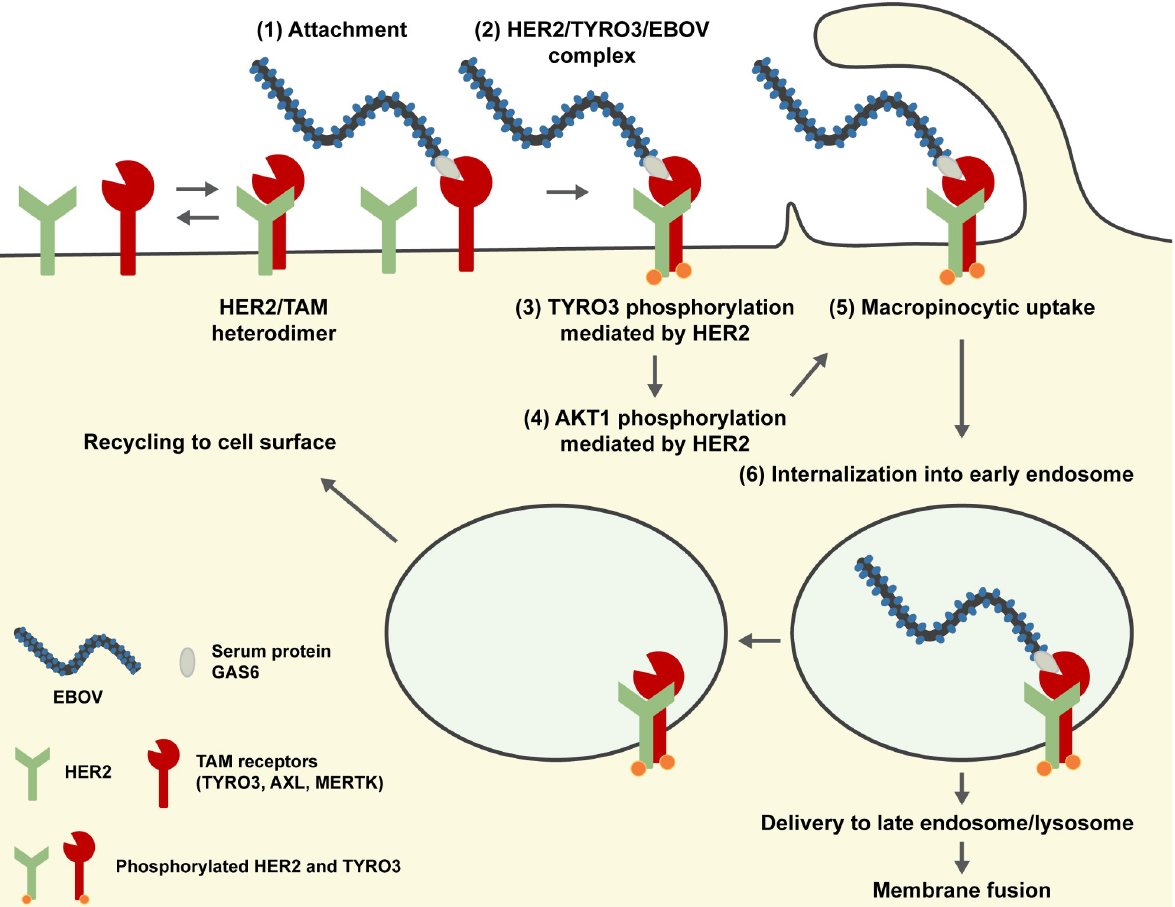
Fig 8. Proposed model of EBOV entry into cells expressing HER2 and TYRO3. HER2 interacts with all members of the TAM (TYRO3, AXL, and MERTK) receptor family to form heterodimers. In TAM receptor-mediated cellular entry, EBOV particles attach to the cell surface by binding to a TAM receptor (e.g., TYRO3) via the serum protein GAS6 (1). HER2 also interacts with the virus-bound TYRO3, forming a HER2/TYRO3/EBOV complex on the cell surface (2). The formation of this complex leads to HER2 phosphorylation (either autophosphorylation or phosphorylation by an as yet unknown cellular factor) and the phosphorylation of TYRO3 by HER2 (3), leading to downstream activation of PI3K/AKT signaling pathway (HER2-mediated AKT1 activation) (4) and subsequent induction of macropinocytosis (5). After internalization of the HER2/TYRO3/EBOV complexes into early endosomes via macropinocytosis (6), the complexes are disassociated, and only EBOV particles are delivered to late the endosomes/lysosomes, where later events such as membrane fusion occur. HER2 and TYRO3 are most likely recycled back to the cell surface.